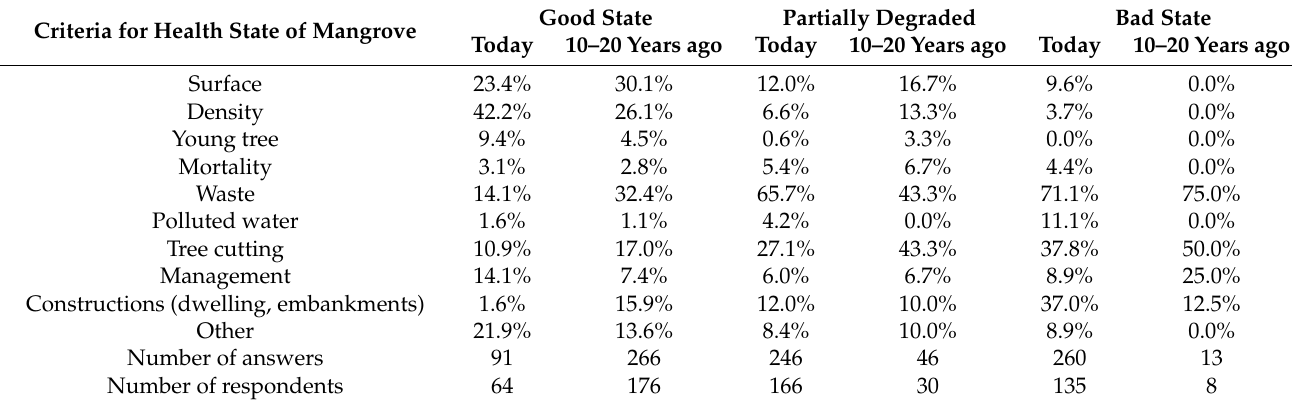
Table 2. Criteria mentioned by surveyed people to justify the health state of the mangrove of their village. Criteria for Health State of Mangrove